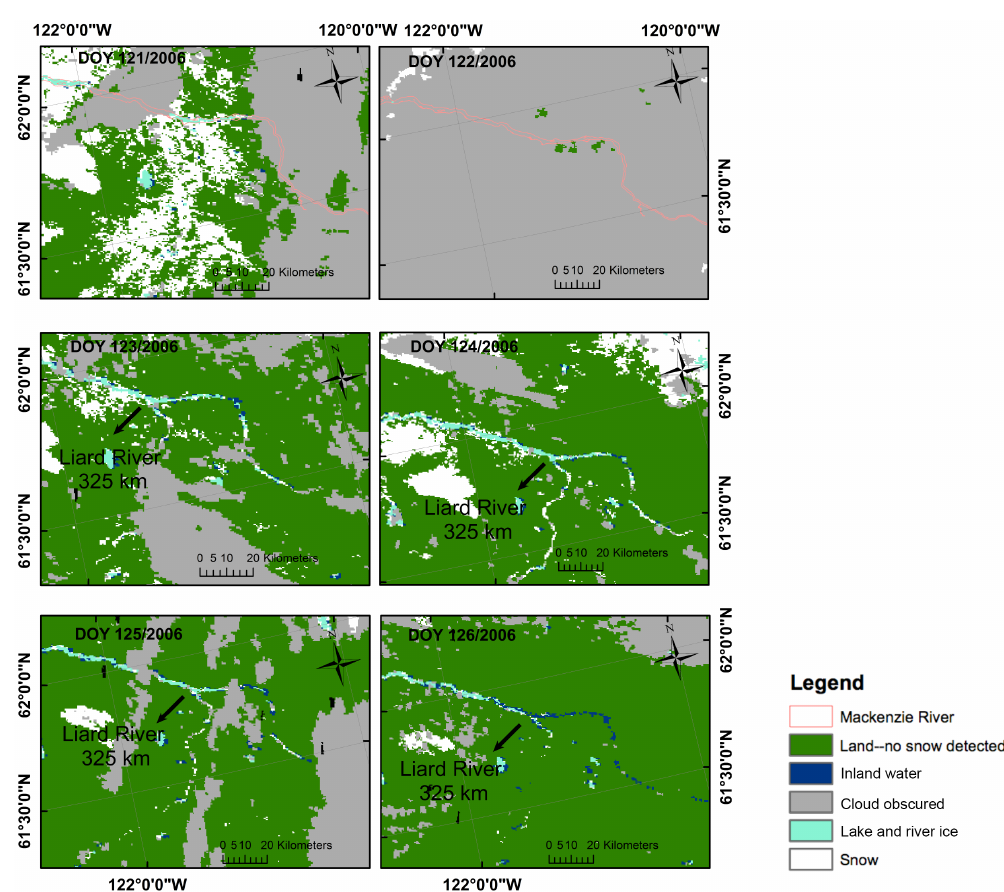
Figure 8. Example of thermodynamic break-up, where ice within the river requires an extra 2–3 days to be cleared after snow has melted over the immediate drainage basin. This process was observed in 2006 between DOYs 121 and